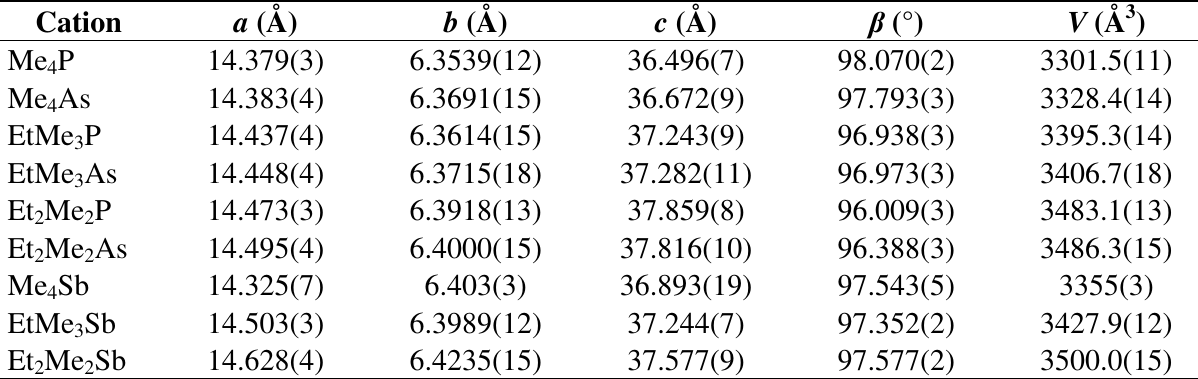
Figure 3. Lattice constants of β '-(Et covalent radius of the central atom Z ( R